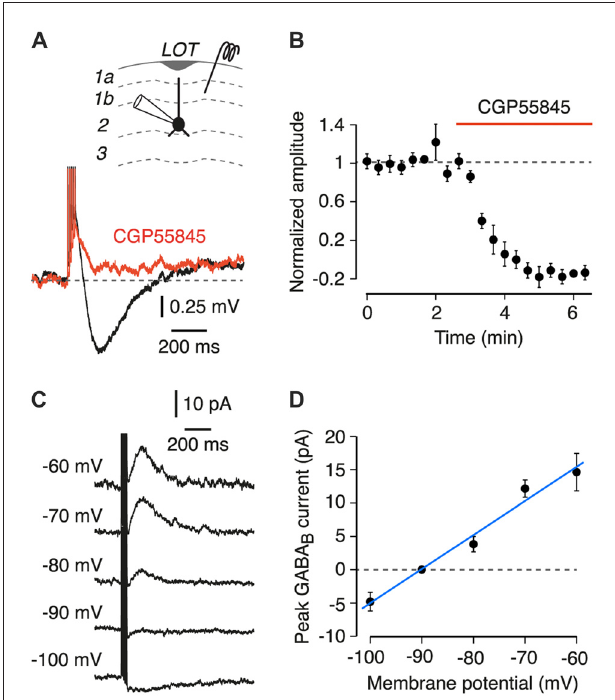
FIGURE 2 | Postsynaptic GABA B receptors suppress the excitability of SL and SP cells. (A) Typical GABA B receptor-mediated postsynaptic potentials in an SL cell (green) and an SP cell (black) resulting from 5-pulse 100 Hz stimuli applied in the layer indicated at left. Each trace is an average of four episodes. Inset shows a schematic of the experiment configuration, with the different stimulator locations indicated. (B) Mean peak postsynaptic GABA B IPSP plotted against layer number for SL cells (green; n = 3) and SP cells (black; n = 5). Green open symbol shows the mean bracketing response of SL cells to layer 1b stimulation at the end of the experiment, confirming absence of run-down. Error bars show ± SEM. (C) Typical result from an experiment in which a depolarizing current ramp was applied in the absence (black trace) or presence (red trace) of a preceding 5-pulse 100 Hz stimulus train to elicit a postsynaptic GABA B receptor response. Gray trace shows the GABA B receptor response without the current ramp. Data are from an SP cell. Region in the dashed box is shown expanded in the inset. Scale bars for inset: 10 mV, 100 ms. (D) Summary data for experiments like in (C) showing that prior activation of postsynaptic GABA B receptors increases the latency to the first action potential (AP) fired in response to the current ramp. CON, control. Combined data from n = 5 SL and SP cells. ns , not significant; ∗ p < 0.05; ∗∗ p < 0.01; ∗∗∗ p <